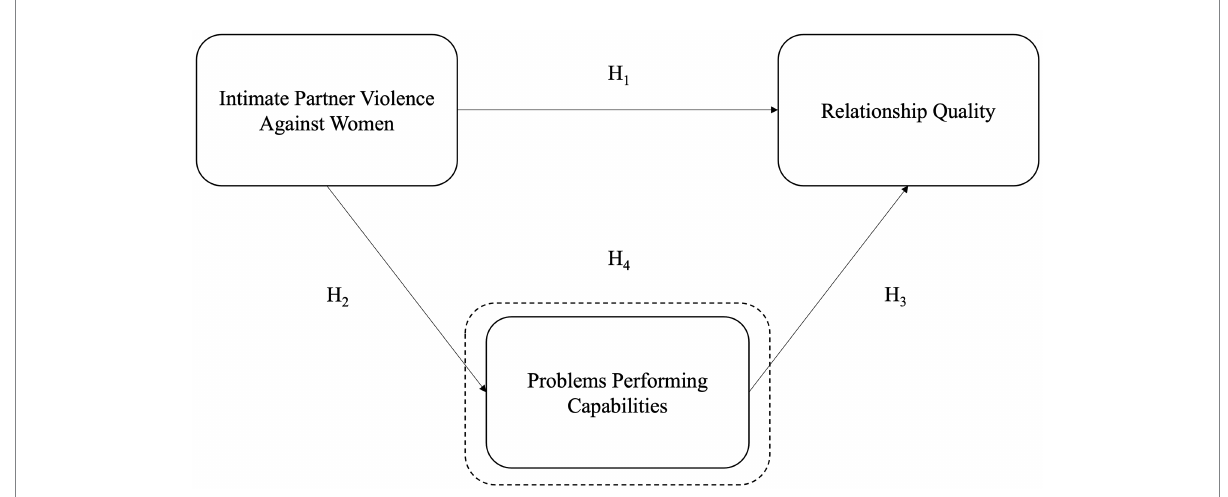
FIGURE 1 Conceptual framework and hypotheses. The dotted outlining represents the mediating